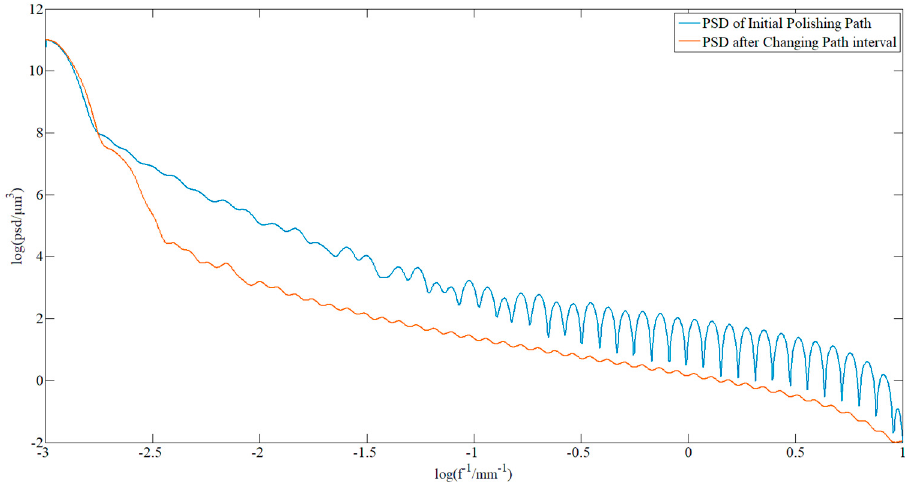
Figure 14. Comparison of the PSD curves of the sample before and after polishing with changing path intervals.